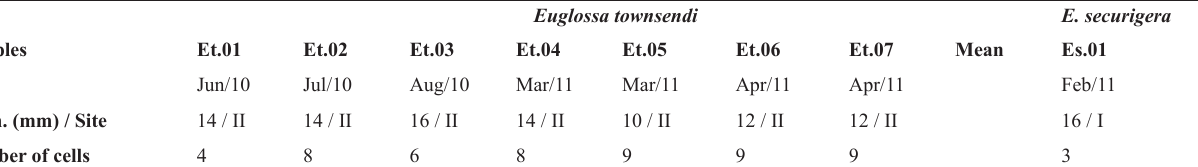
Table 2 . Frequency of occurrence of pollen types in Euglossa townsendi and E. securigera nests.